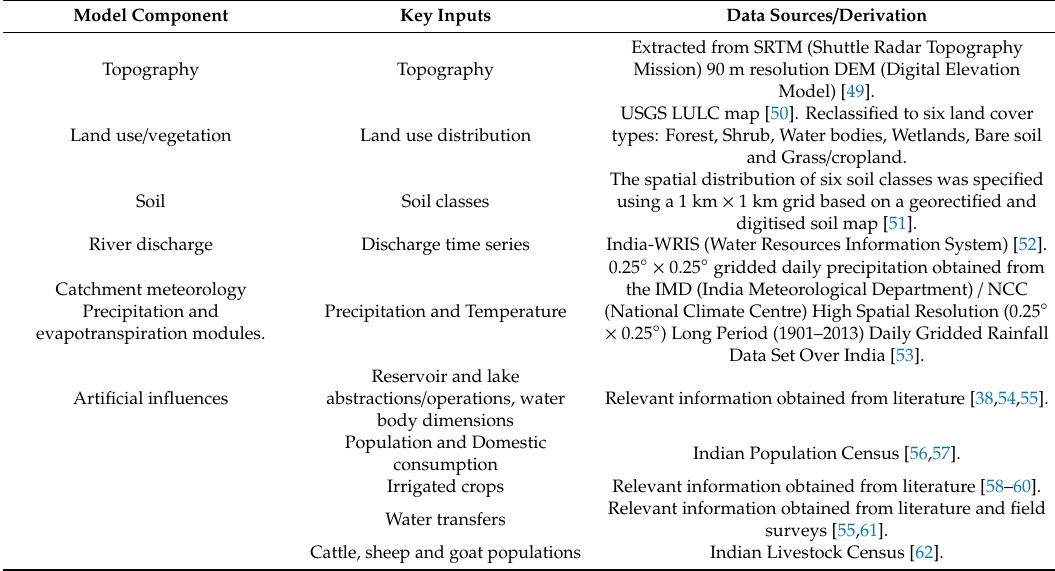
Table 1. Data sources used for Global Water Availability Assessment (GWAVA) model